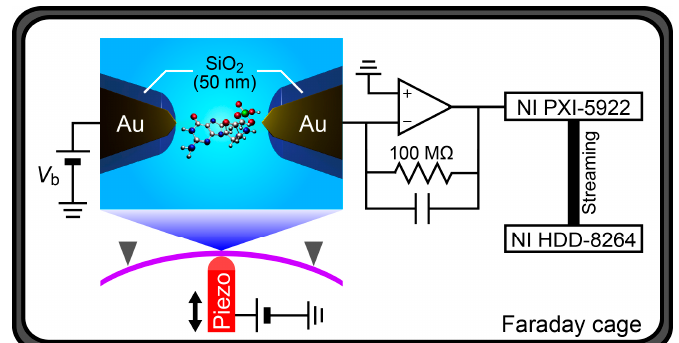
Figure 1. Schematic description of the tunneling current measurement setup. SiO 2 ‐ coated Au nanoelectrodes were connected to feedthrough for biasing the dc voltage V b and amplifying the current by the amplifier. The output voltage was digitized and stored in a hard disk drive.